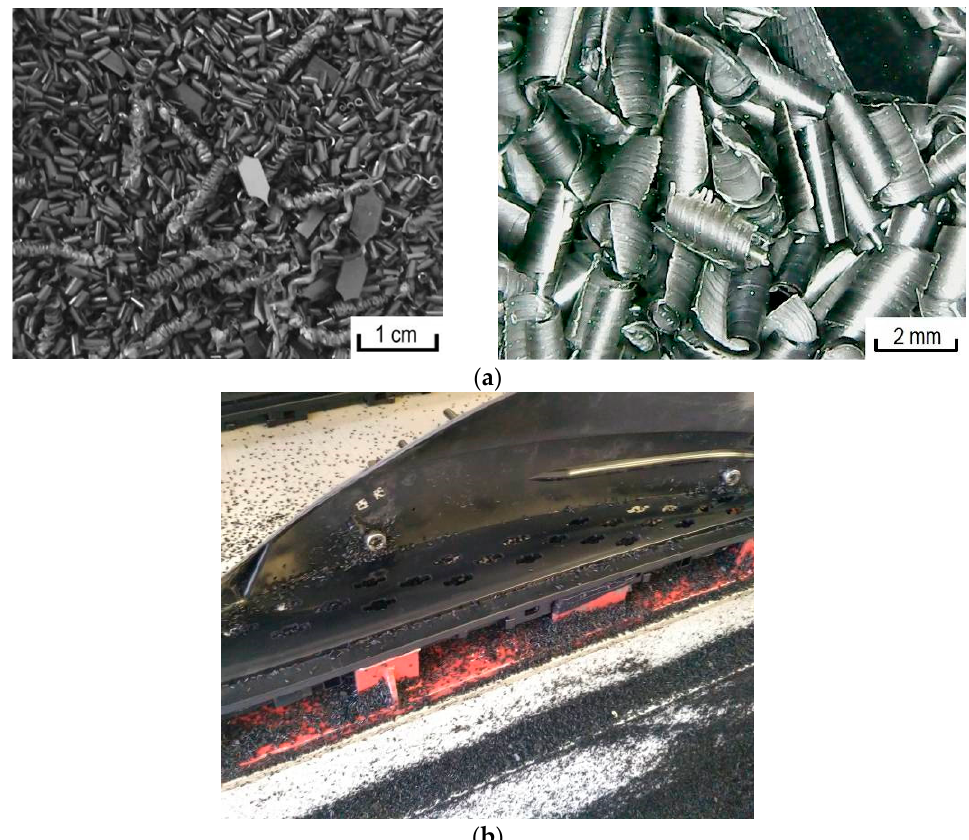
Figure 1. Polypropylene waste ( a ) obtained by milling panels ( b ) for forming cutouts.